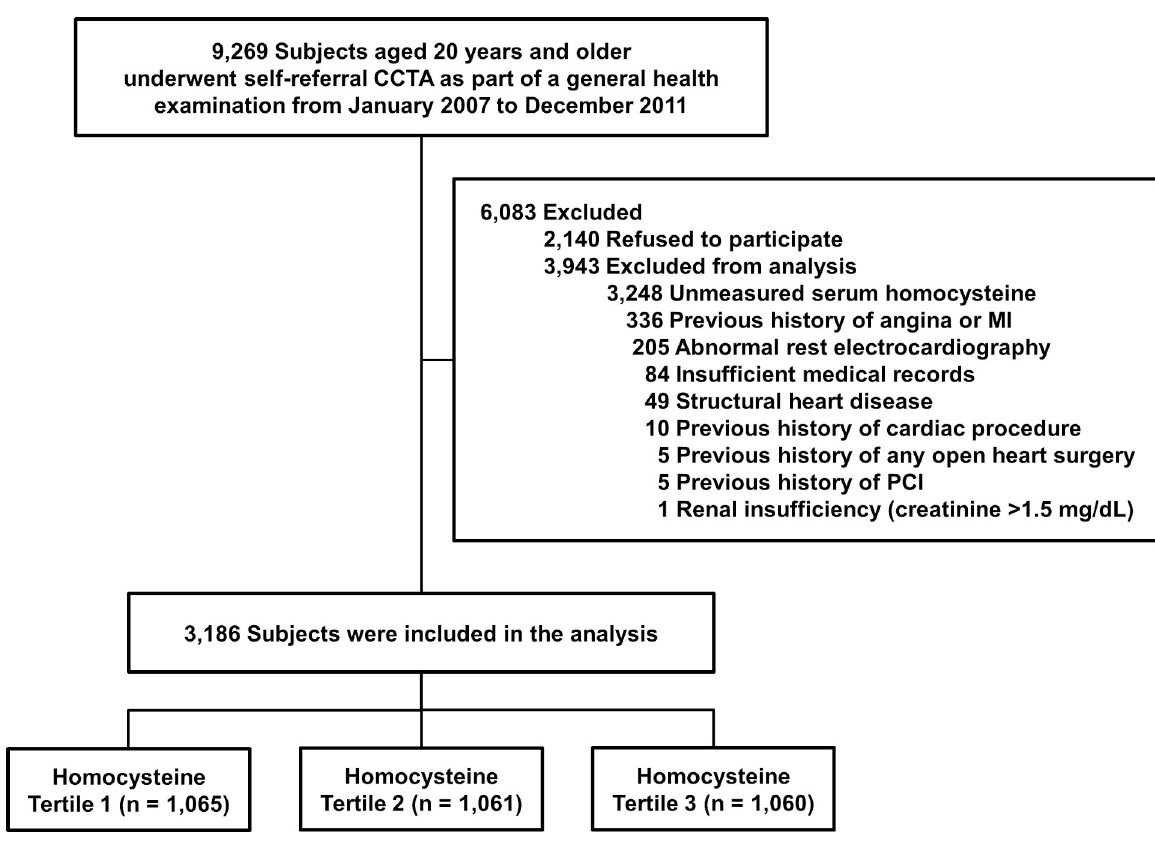
Fig 1. Overview of the study population. CCTA = coronary computed tomographic angiography; MI = myocardial infarction; PCI = percutaneous coronary